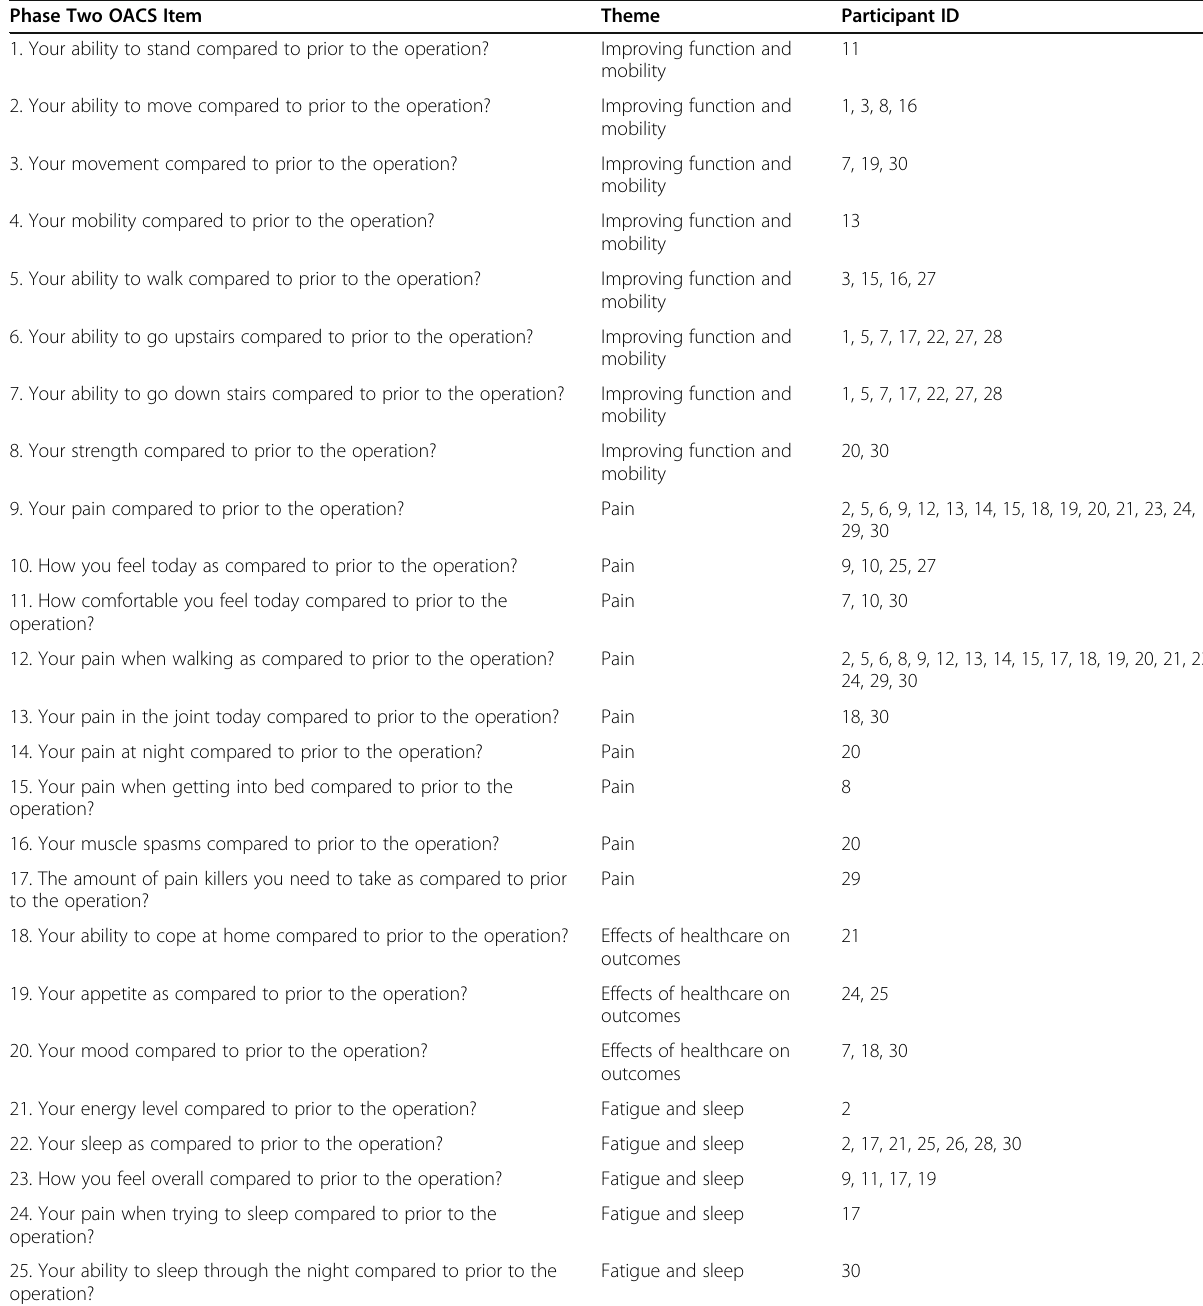
Table 5 Pilot OACS items and themes breakdowns Phase Two OACS